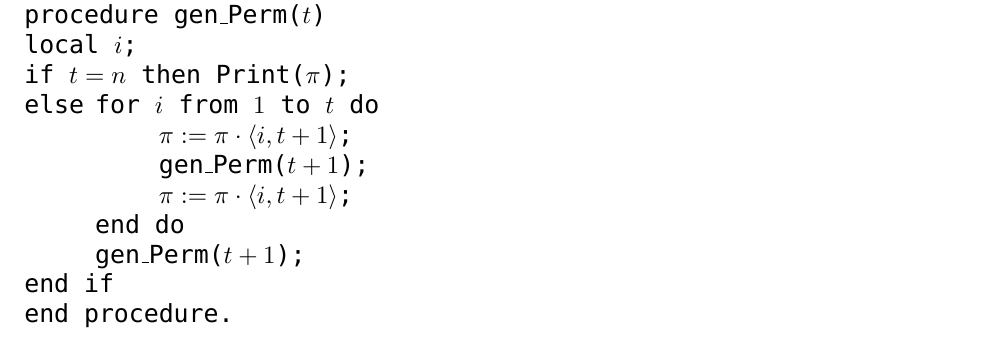
Algorithm 1 Algorithm producing exhaustively length- n permutations. n and π are both global variables and initially π is 1 2 3 . . . n ∈ S n . The main call is gen Perm( 1 ) and the statement π := π · h i, t + 1 i after each recursive call restores the value of π before this